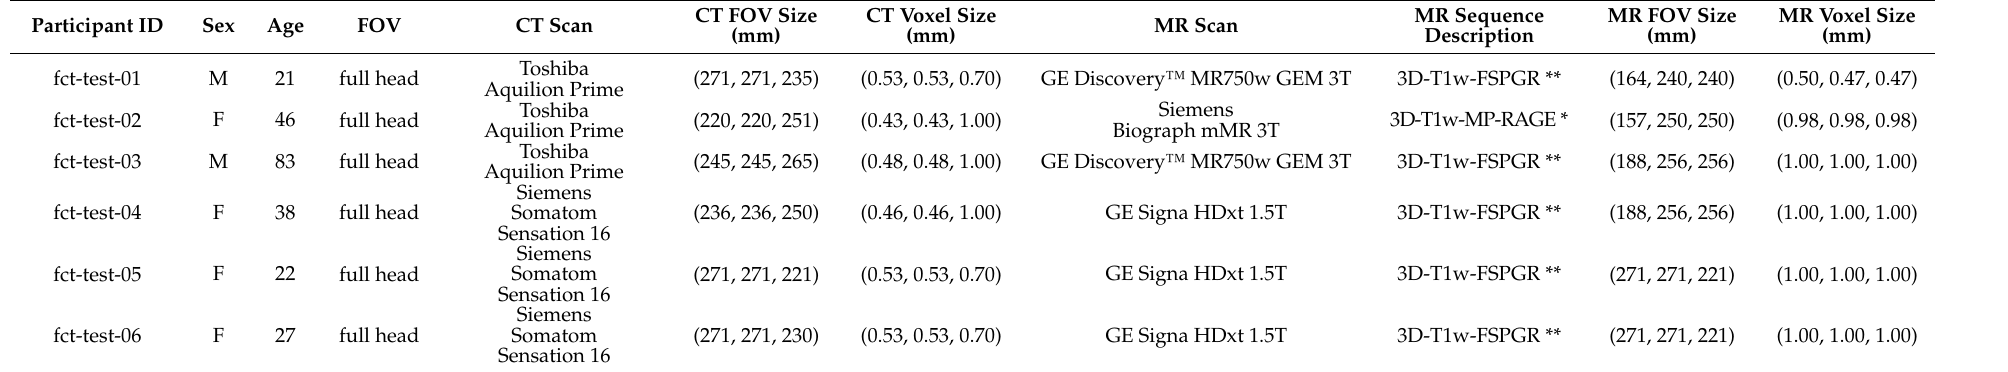
Table A2. Extended demographic and technical details from patients included in validation